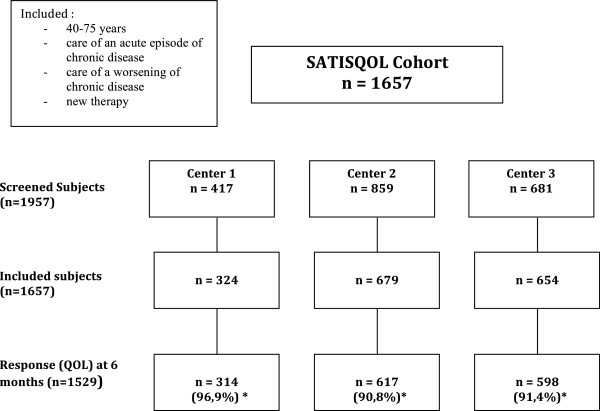
Flowchart of the SATISQOL cohort population.